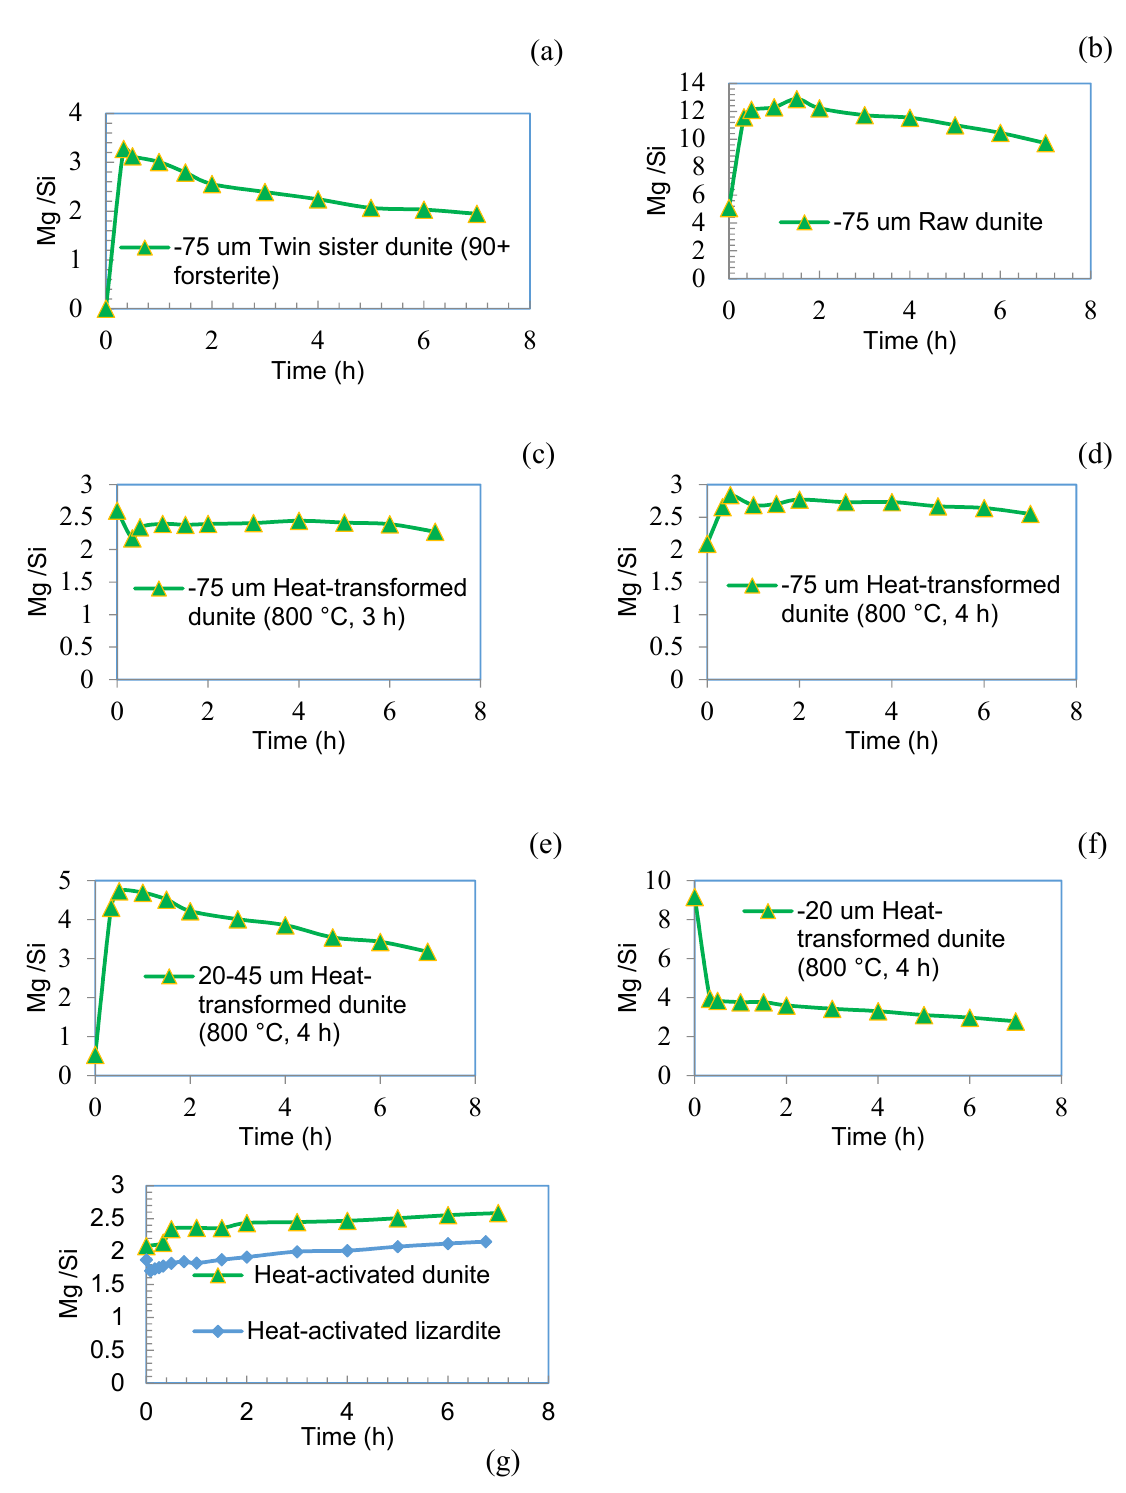
Figure 11. The Mg/Si ratio for different materials: ( a ) sub-75 µm twin sister dunite (more than 90% Figure 11. The Mg / Si ratio for di ff erent materials: ( a ) sub-75 µ m twin sister dunite (more than 90% forsterite) taken as reference; ( b ) sub-75 µm raw dunite; ( c ) sub-75 µm heat-transformed dunite forsterite) taken as reference; ( b ) sub-75 µ m raw dunite; ( c ) sub-75 µ m heat-transformed dunite (800 ◦ C, (800 °C, 3 h); ( d ) sub-75 µm heat-transformed dunite (800 °C, 4 h); ( e ) 20–45 µm heat-transformed 3 h); ( d ) sub-75 µ m heat-transformed dunite (800 ◦ C, 4 h); ( e ) 20–45 µ m heat-transformed dunite (800 ◦ C, dunite (800 °C, 4 h); ( f ) sub-20 µm heat-transformed dunite (800 °C, 4 h); and ( g ) sub-75 µm heat- 4 h); ( f ) sub-20 µ m heat-transformed dunite (800 ◦ C, 4 h); and ( g ) sub-75 µ m heat-activated dunite activated dunite (630 °C, 4 h). (630 ◦ C, 4